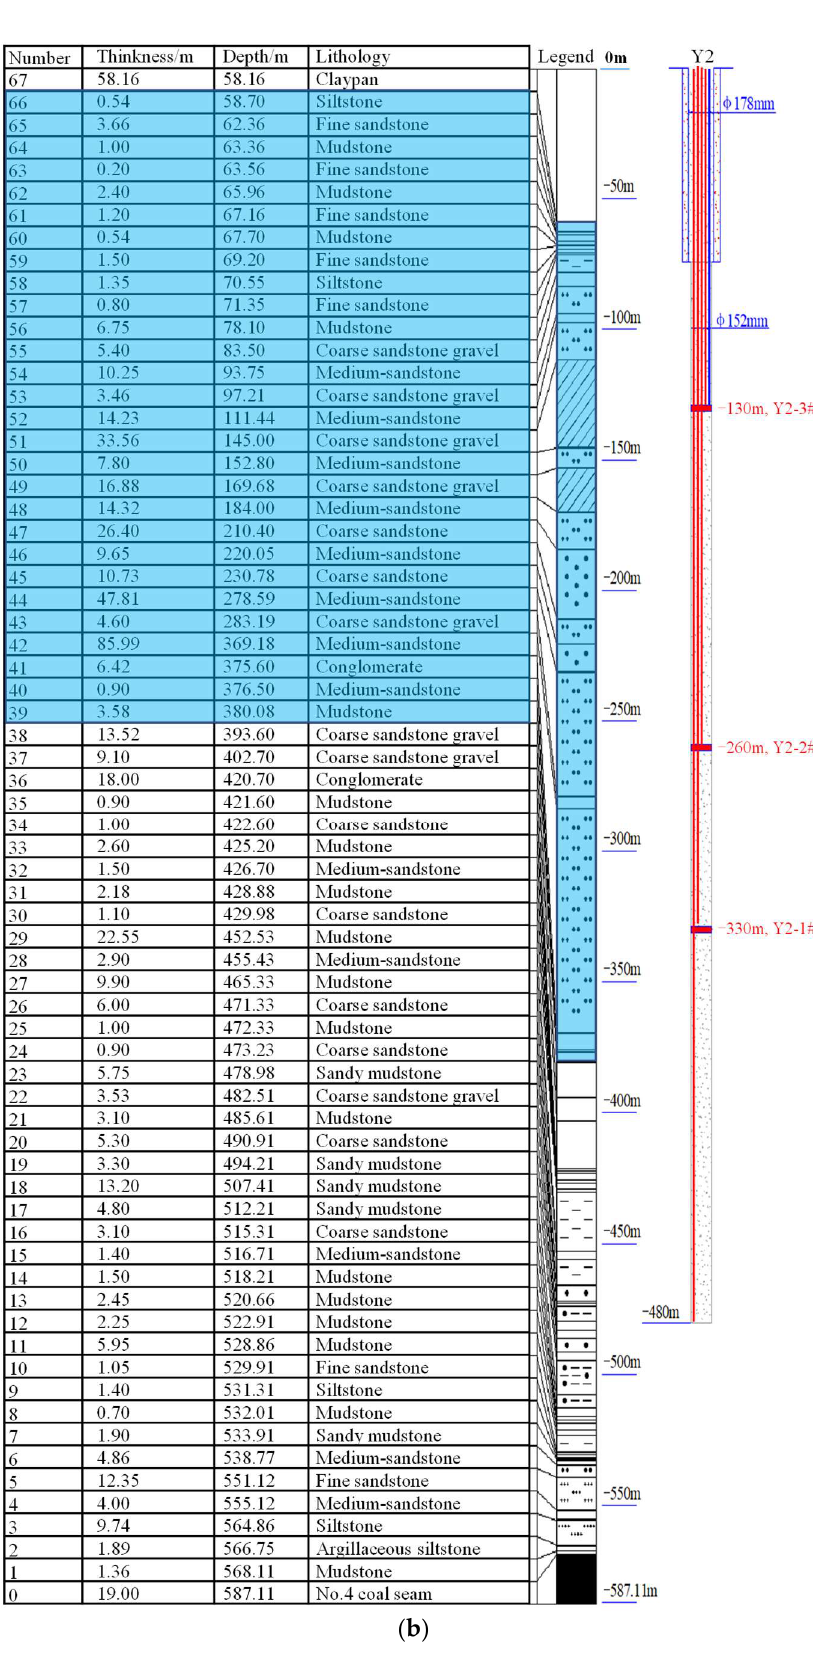
Figure 6. Positions of the borehole MPBXs with respect to the stratigraphic column. ( a ) No.Y1-1 and No.Y1-2 borehole, and ( b ) No.Y2 borehole.